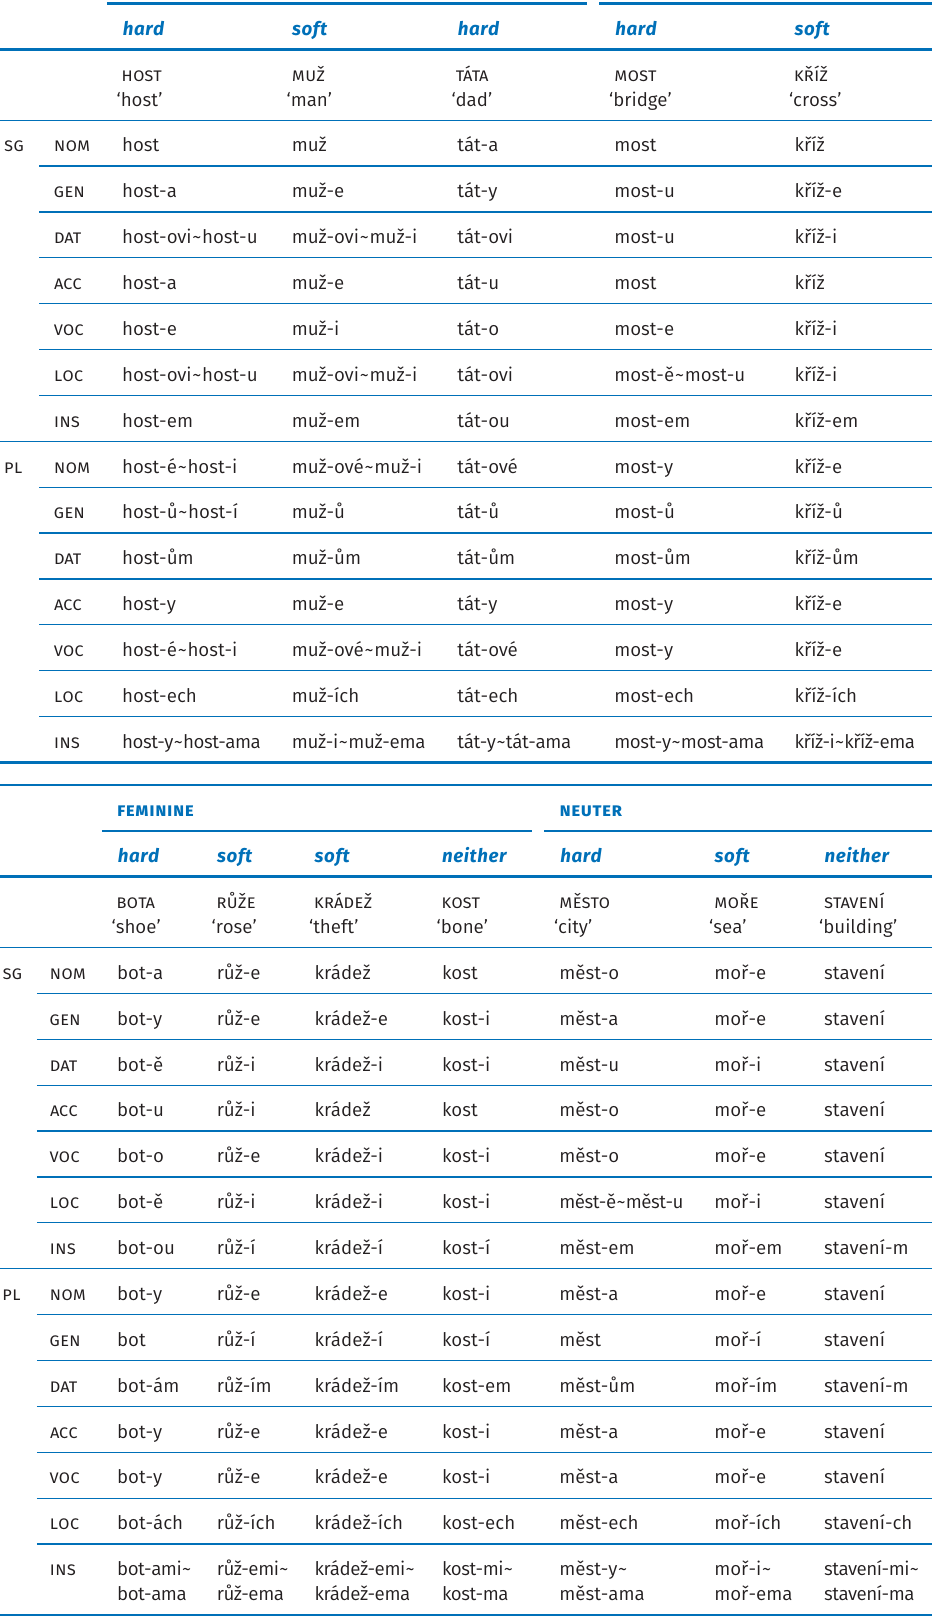
Table 1 Main Czech inflection